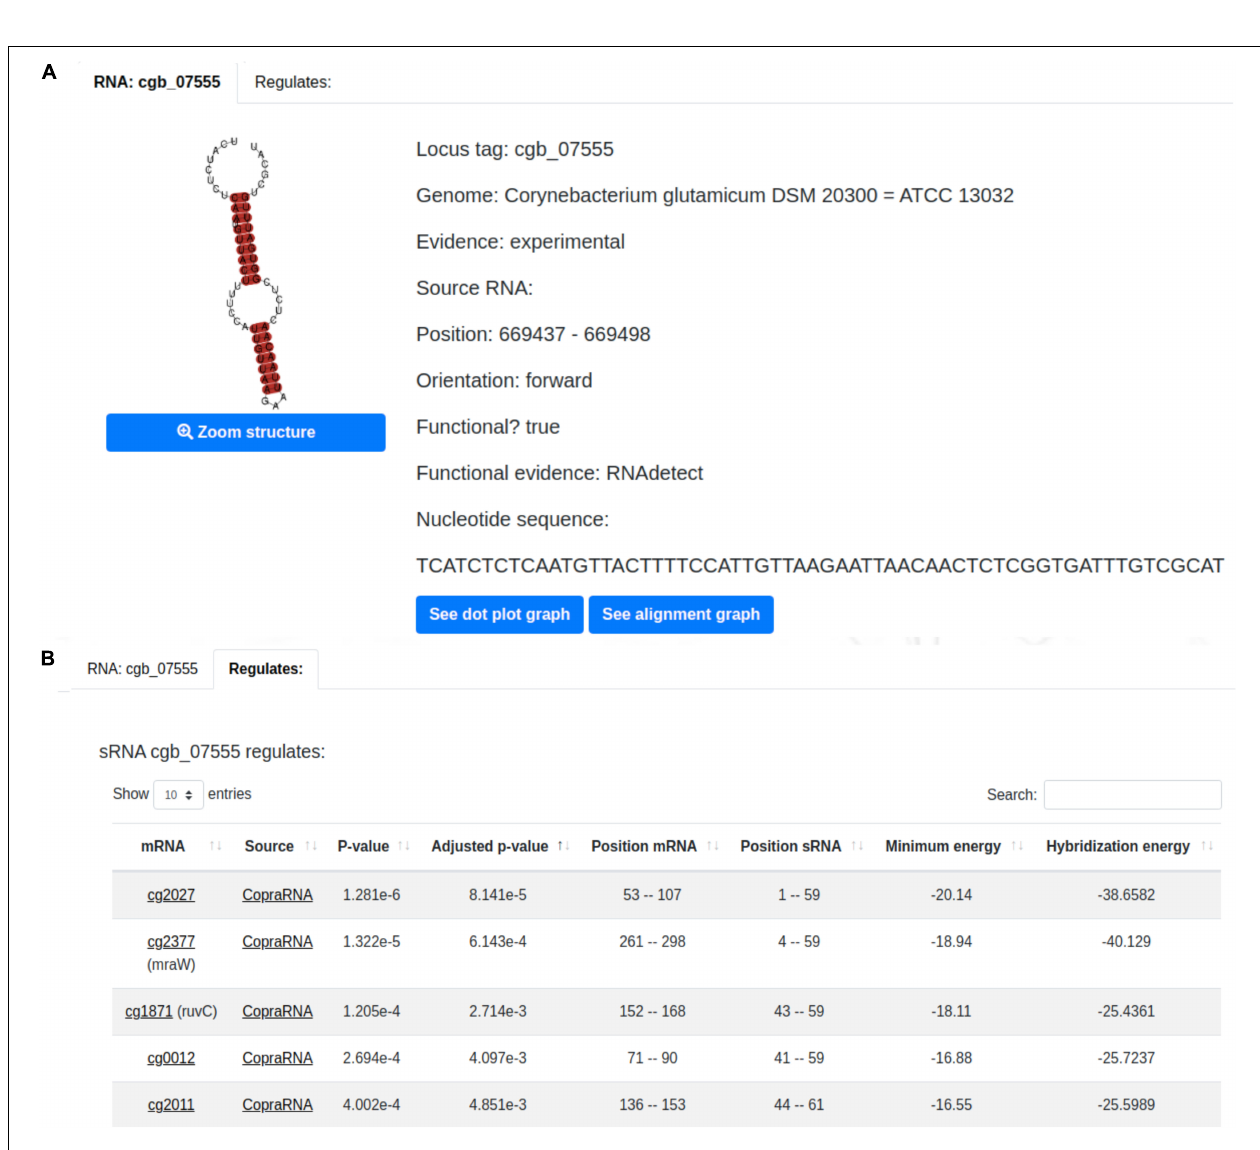
Frontiers in Microbiology |